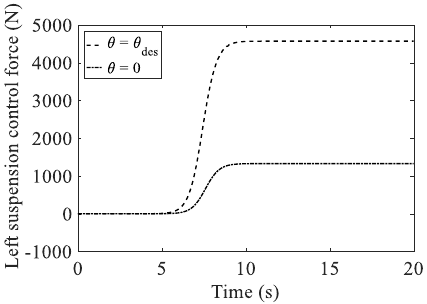
Figure 9. Left suspension control force.